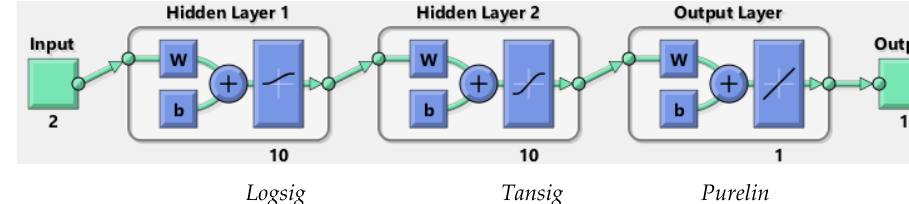
Figure 3. Topology of the selected ANN. Table 1. The summary of the final ANN network .